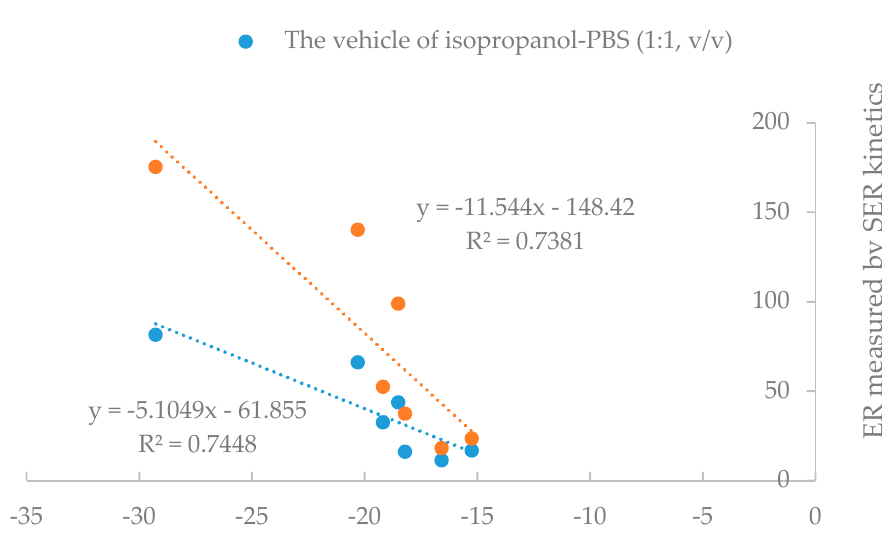
Figure 8. The correlation between enhancement ratio (ER) measured by SER kinetics and interaction energy of formation of terpene-ceramide complexes.